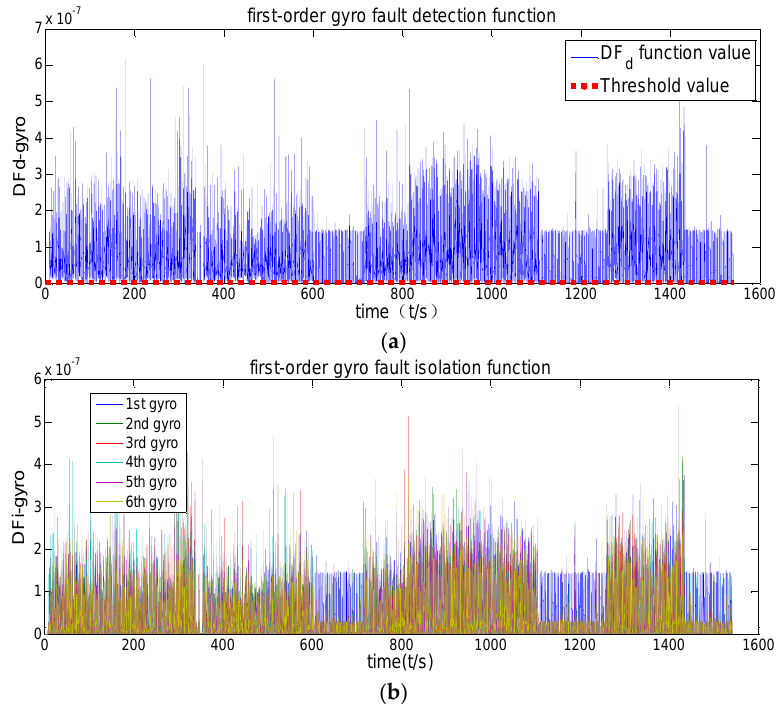
Figure 9. First-order channel filter (the fault amplitude is 0.5 ◦ /h). ( a ) Fault detection; ( b ) Fault isolation.